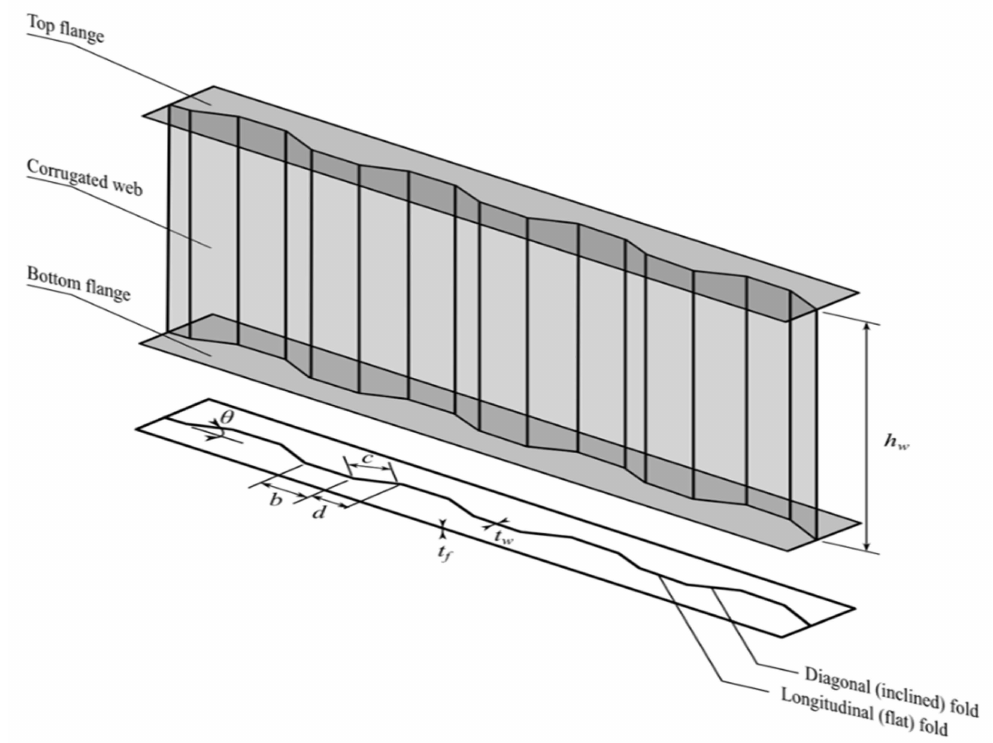
Figure 1. Corrugated web panel.